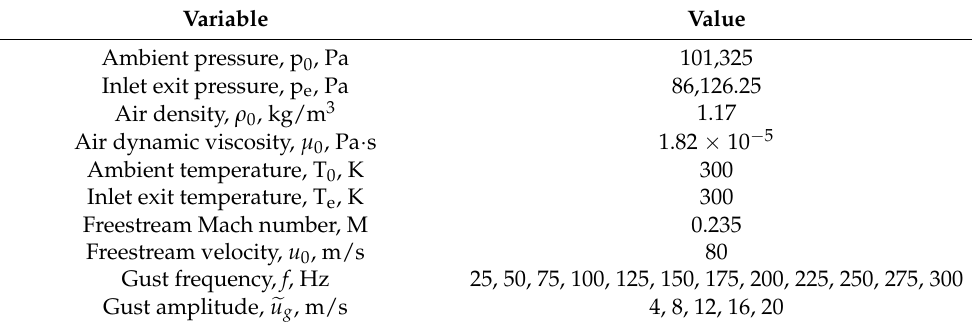
Table 4. Values of the material parameters for the inlet gust response